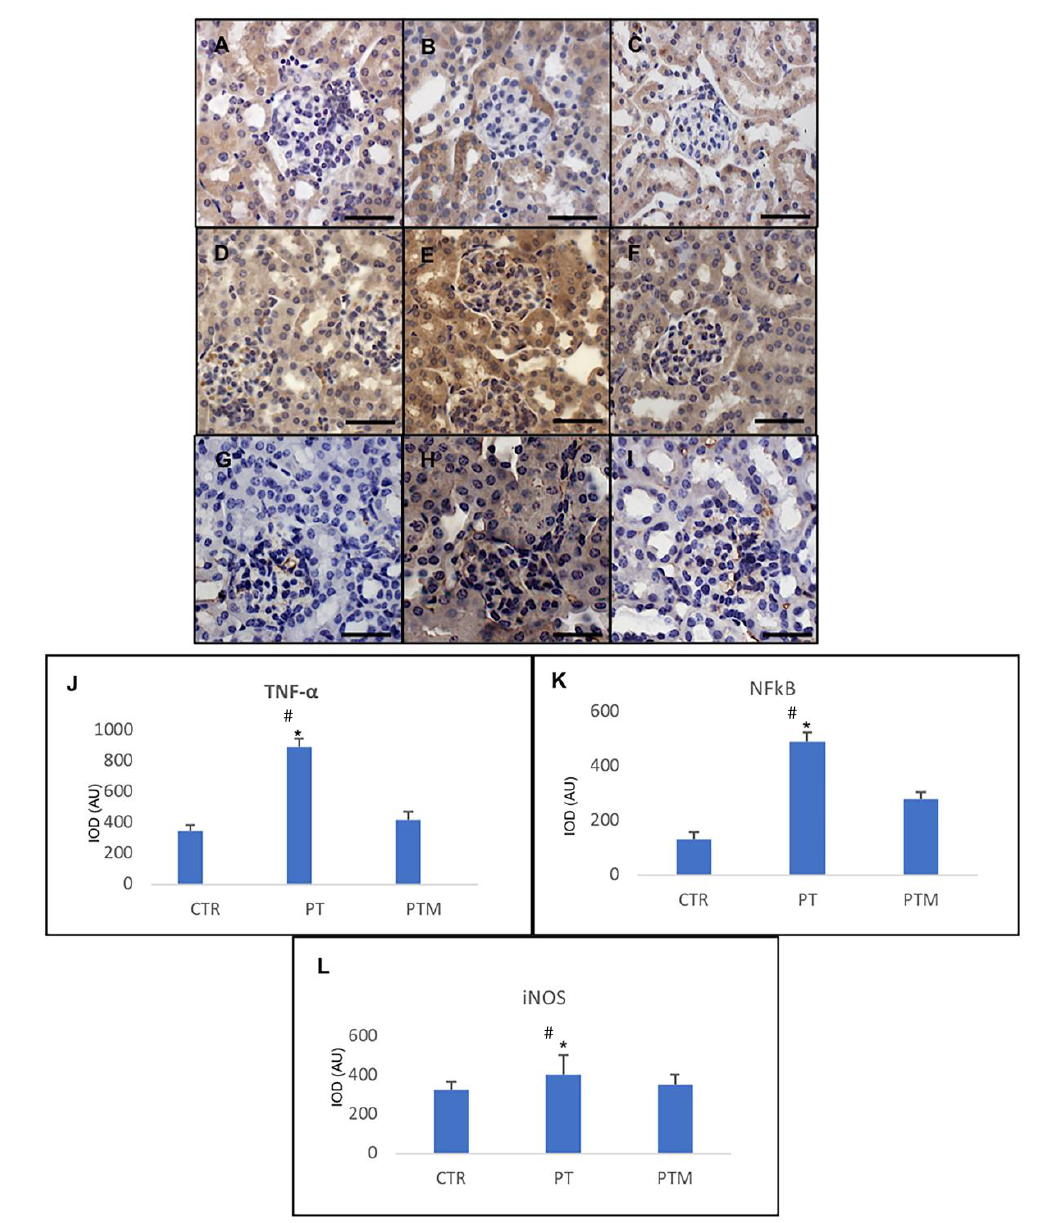
Figure 5. Photomicrographs showing transforming TNF-α ( A – C ), NF-kB ( D – F ) and iNOS ( G – I ) immunohistochemistry of control mice ( A , D , G ), pristane-LN mice ( B , E , H ) and pristane-LN mice treated with melatonin ( C , F , I ). Bar equals 20 μm. The graphs ( J – L ) summarizes proteins immunohistomorphometrical analysis of all experimental groups. *# indicate respectively statistically significant differences vs control and pristane-LN mice treated with melatonin: p < 0.05. CTR: control mice PT: pristane-LN mice PTM: pristane-LN mice treated with melatonin.